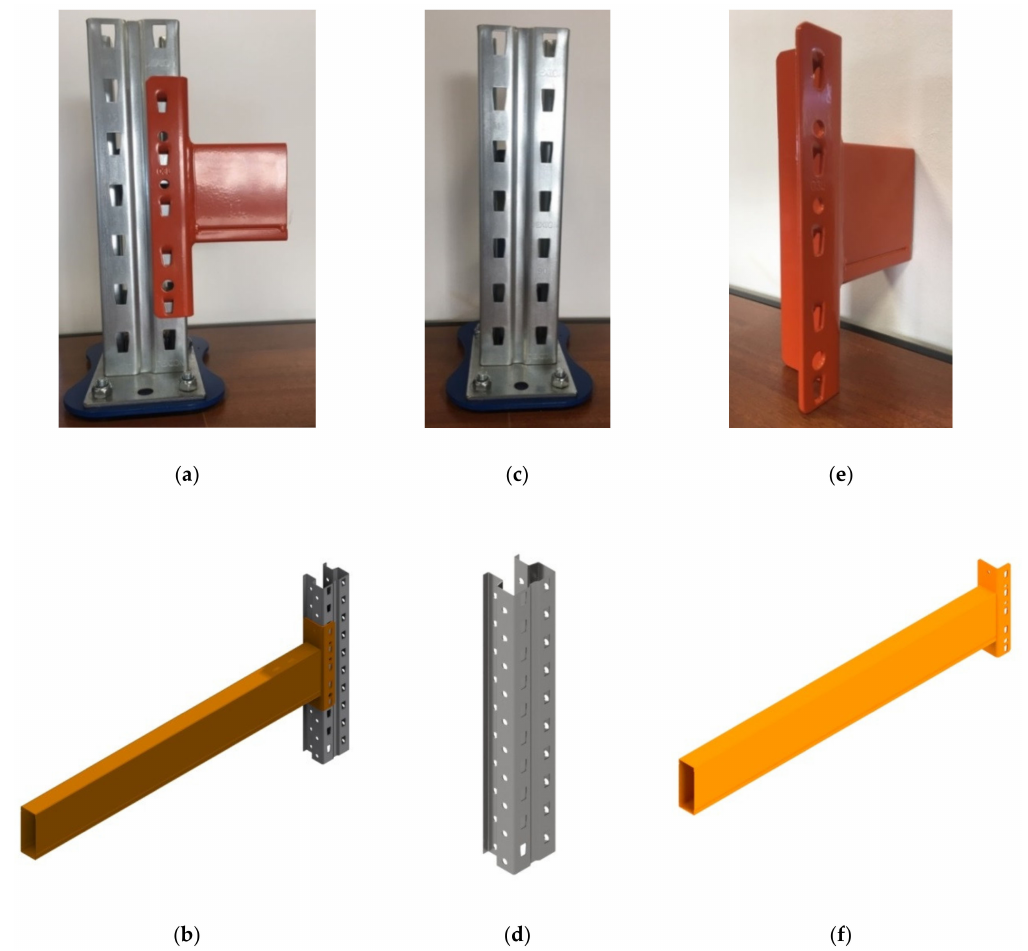
Figure 1. Main elements of the connections tested: ( a , b ) upright-connector-beam assembly, ( c , d ) upright, ( e , f ) beam with welded beam end connector.